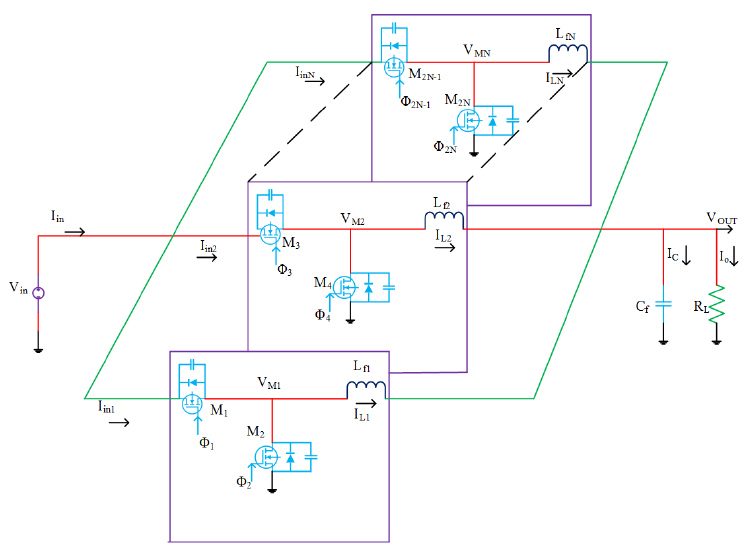
Figure 12. Circuit diagram of multistage interleaved synchronous DC–DC buck converters [87]. Reproduced from [87], IEEE Transactions on Power Electronics: 2007.